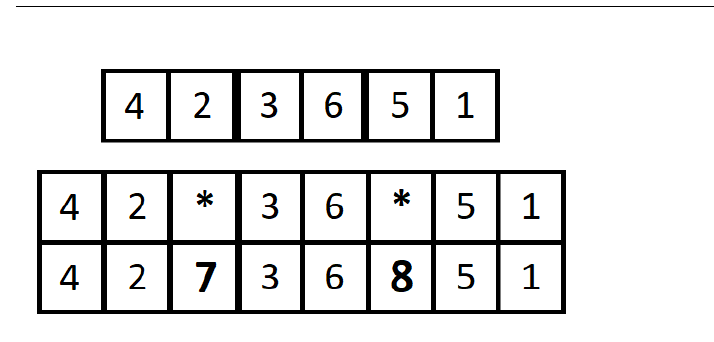
Figure 5. Chromosome representation. In the first representation, the end of segments are represented by wider separator lines. In the second representation, star symbols represent the inserted break points. Break points are replaced by numbers in the final